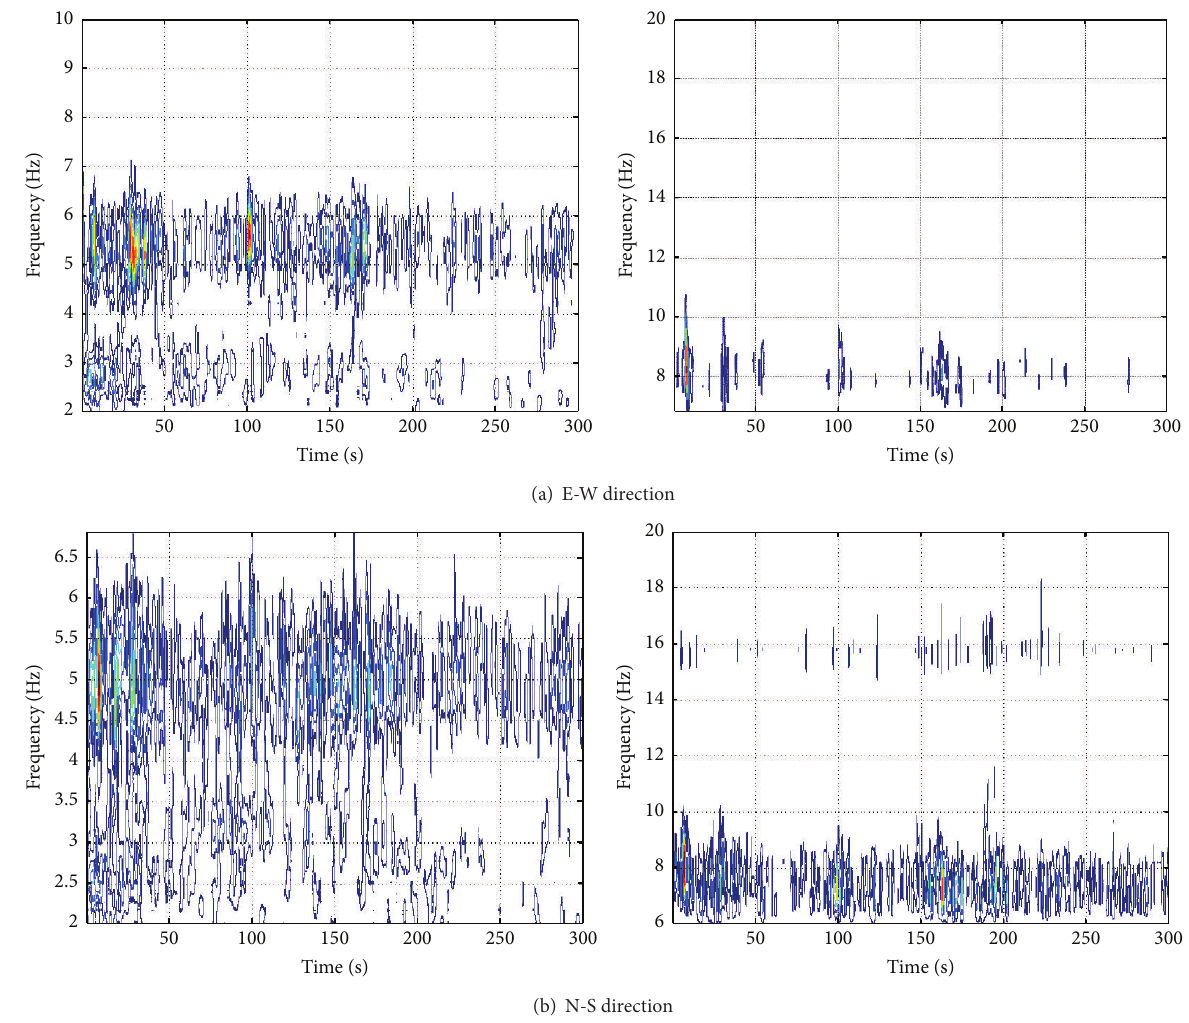
Figure 19: Time-frequency plot of modulus of CWT coefficients in (a) E-W direction and (b) N-S direction.